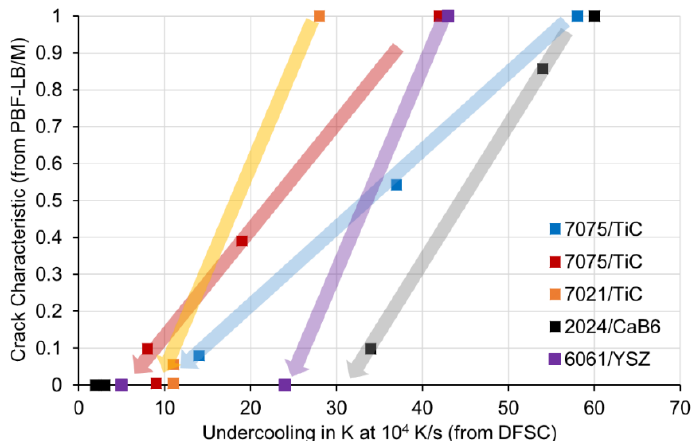
Figure 4. Correlation between crack characteristics C and solidification undercooling with arrows as guides for the eye. Relative crack characteristics of 2024/CaB 6 and 6061/YSZ have been calculated from